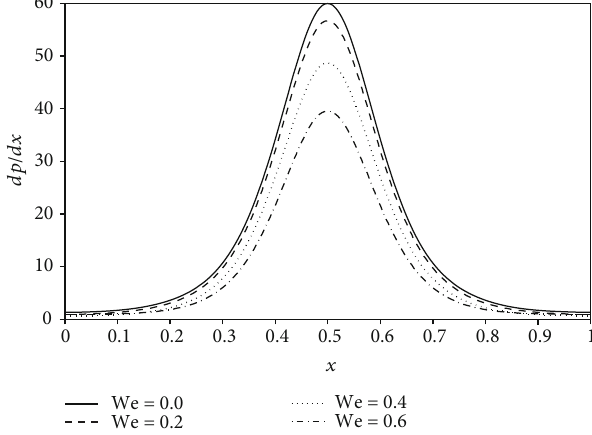
Figure 5: Variation of pressure gradient with x for di ff erent values of β for fi xed values of ϕ = 0 : 5 , n = 0 : 5 , We = 0 : 4 , and Q = − 2 .